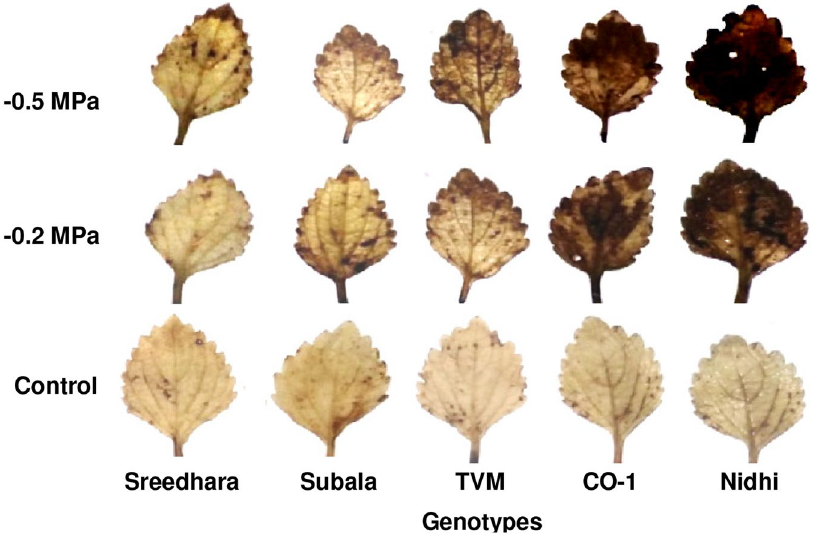
Figure 3. Effect of in vitro PEG mediated osmotic stress on in situ detection of ROS in leaf tissues of Chinese potato